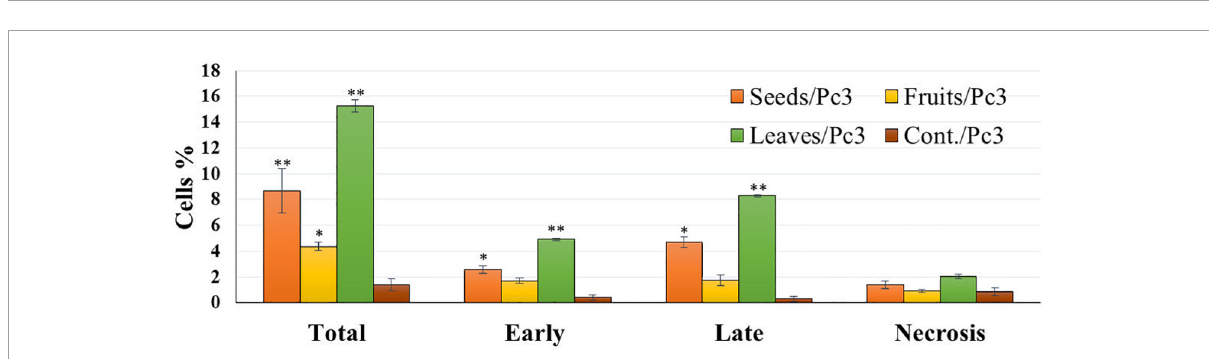
FIGURE5 Percentages of apoptotic and necrotic cells in and Pc3 cell population after treatment with leaf, seed, and fruit extract separately. * P -value was considered statistically significant ( P < 0.05) and ** P -value was considered highly significant ( P < 0.01).